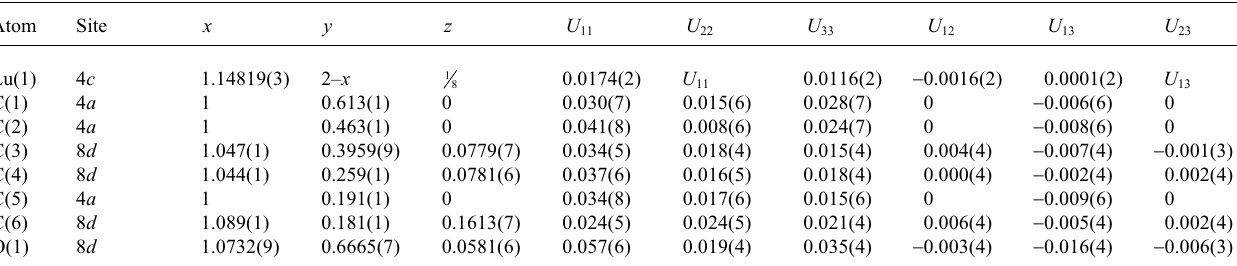
Table 3. Atomic coordinates and displacement parameters (in Å 2